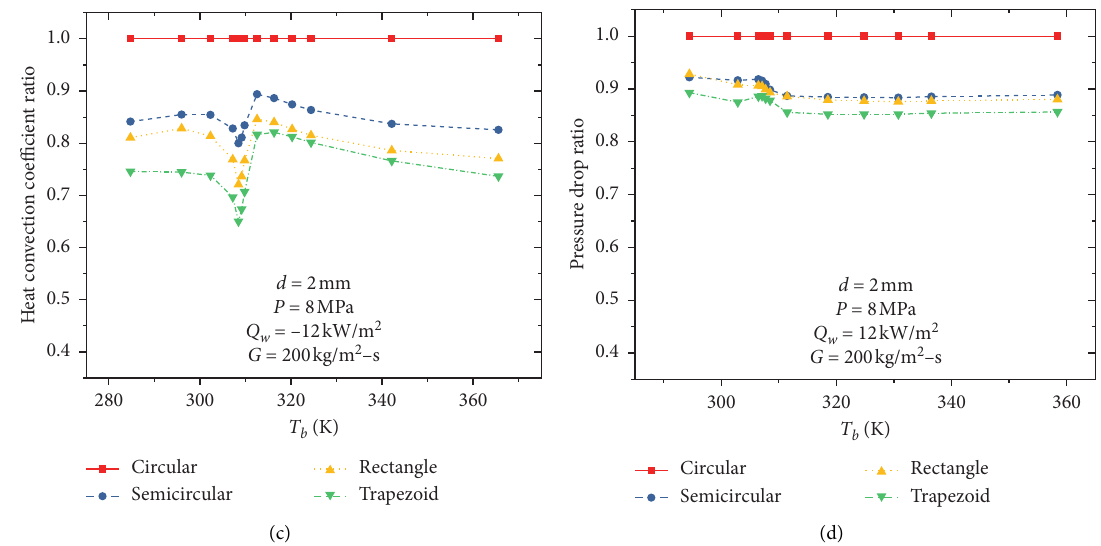
Figure 7: Heat convection coefficient and pressure drop enhancement ratio results: (a) e (c) e of the cooling case; and (d) e α